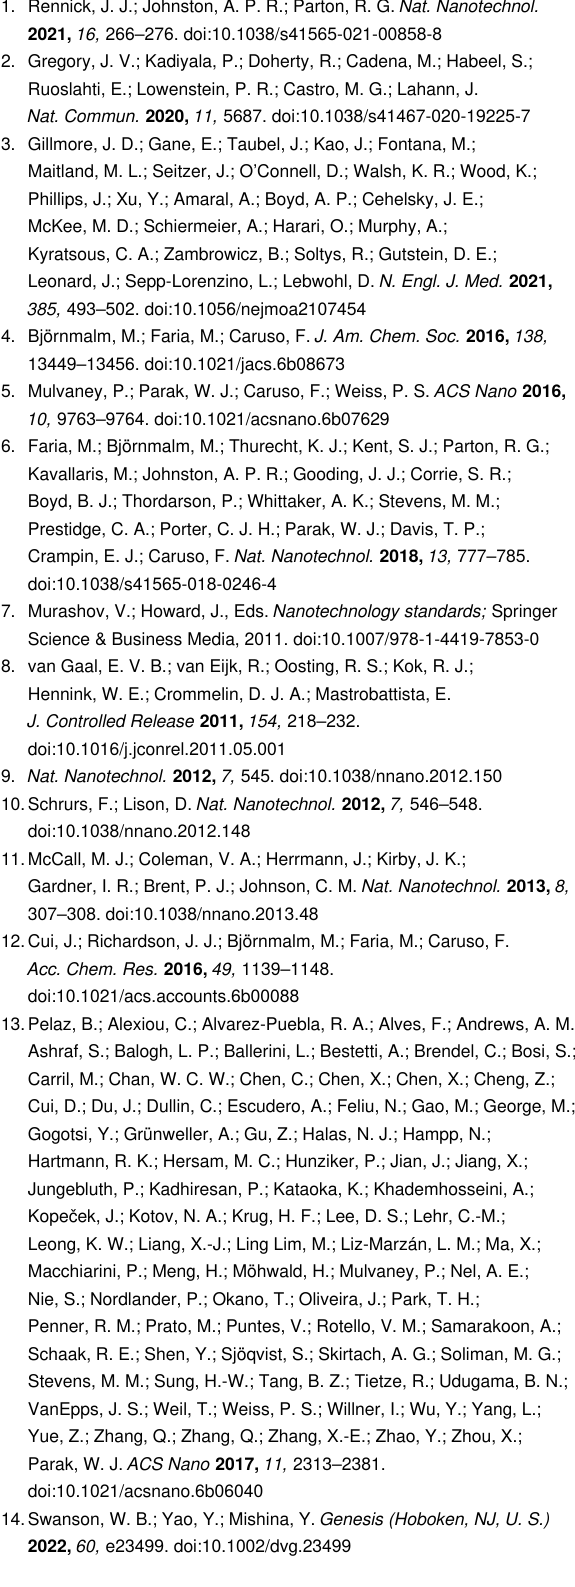
Figure 2 and the Graphical Abstract were created with BioRender.com (https://biorender.com/). This contents are not subject to CC BY